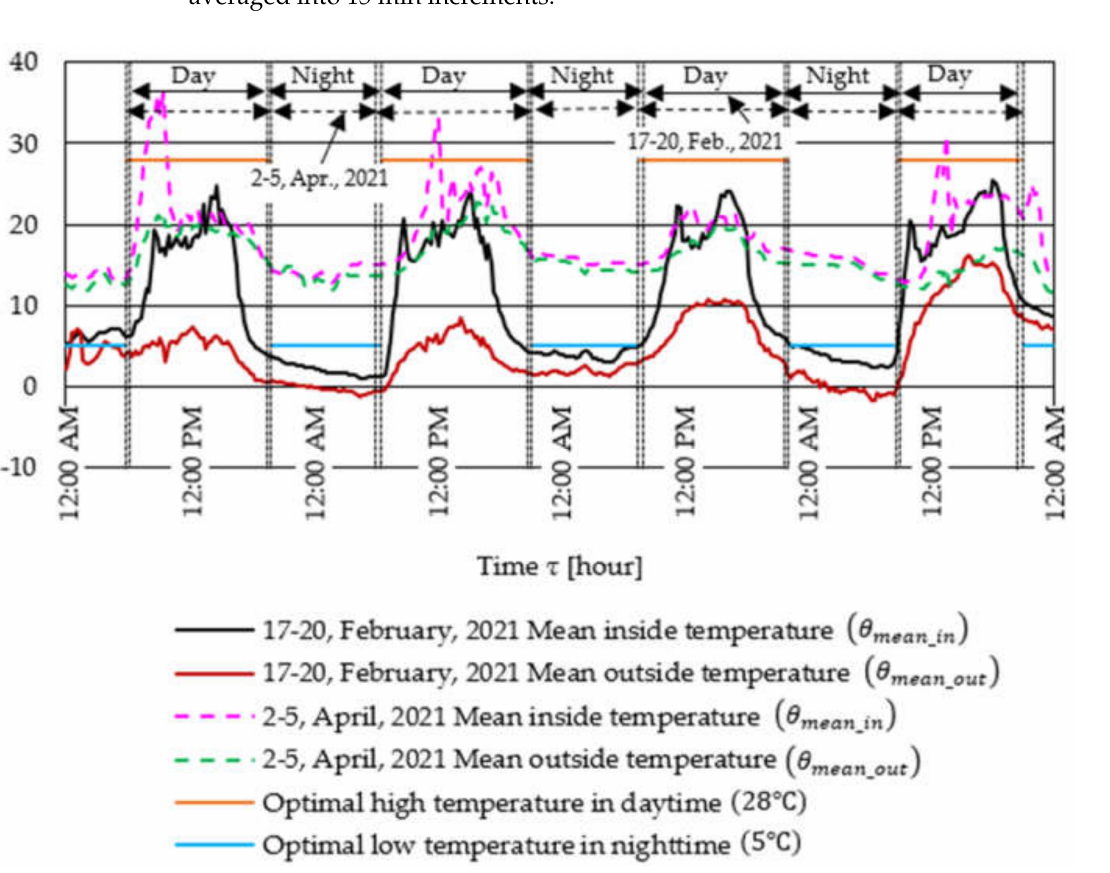
Figure 5. The comparison of the temperatures inside and outside the greenhouse at different times. For 17–20 February 2021, the minimum inside air temperature reached 1.0 ◦ C, and the ambient temperature reached − 1.9 ◦ C in the nighttime. The highest daytime ambient temperature was 16.9 ◦ C when the inside air temperature was 27.1 ◦ C. Moreover, it